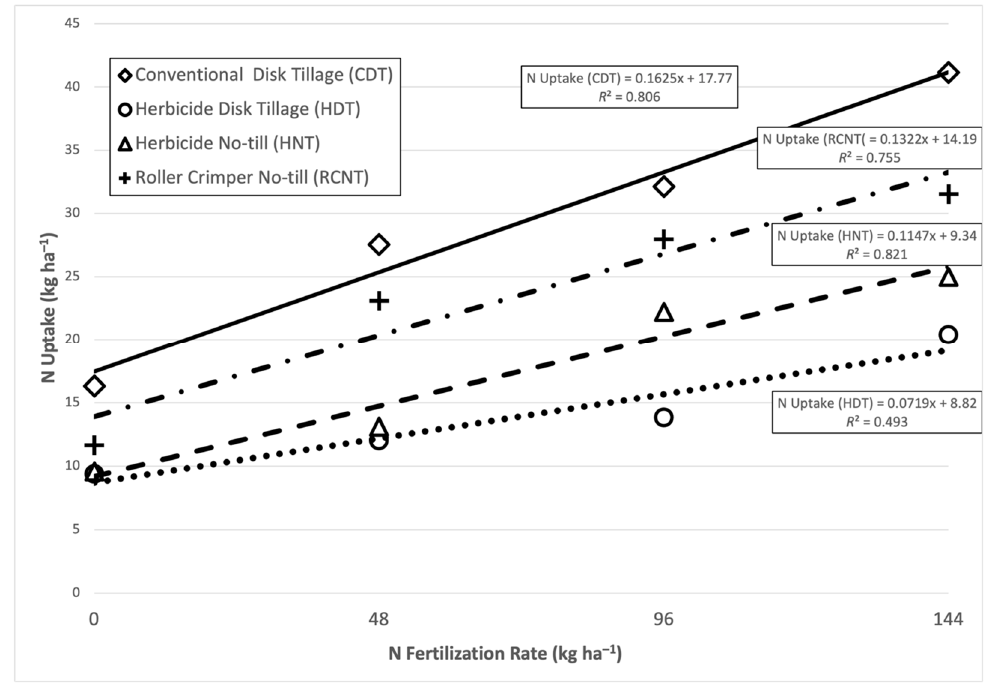
Figure 14. Interactive effect of N fertilization rate following different cover crop termination meth- ods on N uptake in sweet corn in 2021. Goodness of fit described with conditional R 2 .